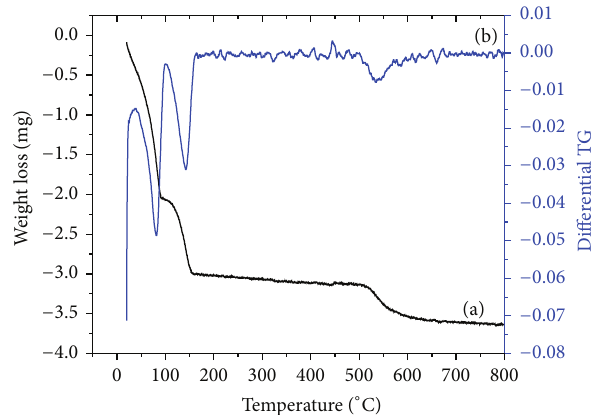
Figure 14: (a) TGA thermograms of NaKP. (b) Differential plot of